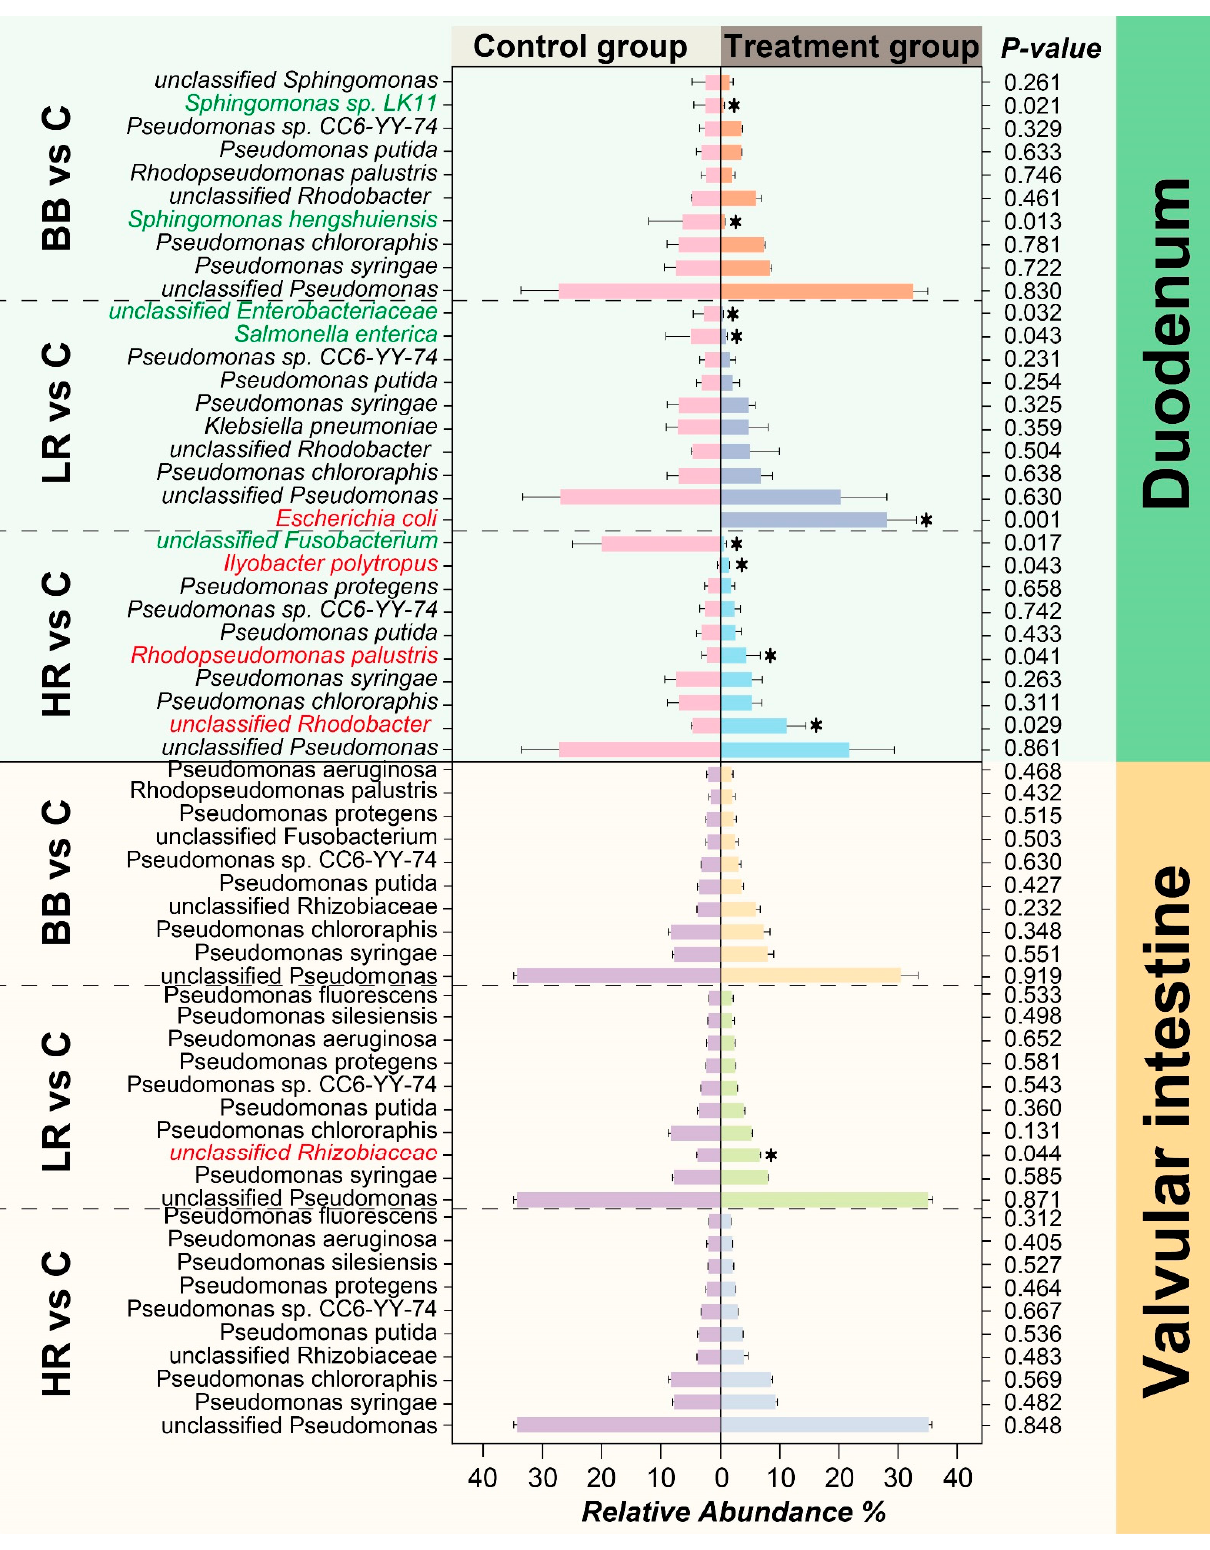
Figure 5. Comparison of microbial community between the treatment and control groups. The chart lists the top 10 abundant communities in the duodenum and valvular intestine in BB vs. C, LR vs. C, and HR vs. C groups. The data are presented as means ± standard deviation, Wilcoxon rank-